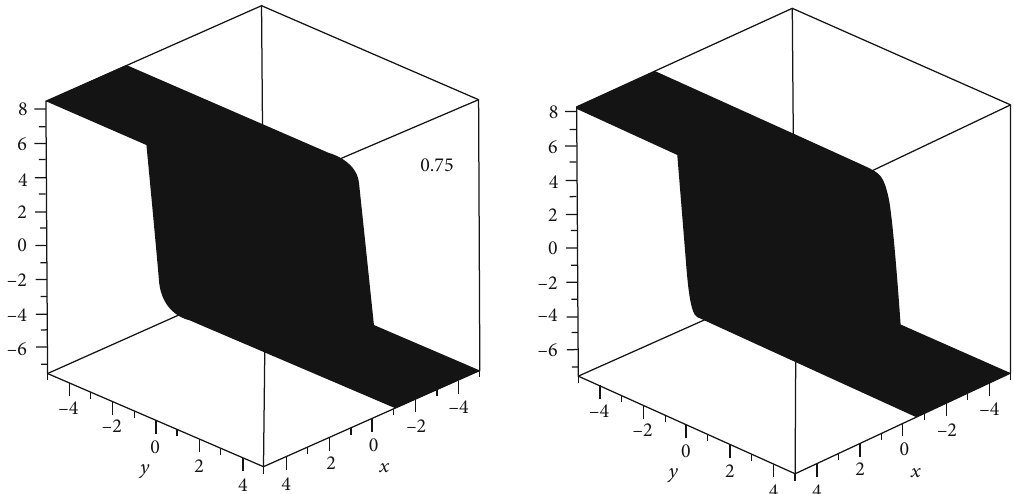
Figure 2: Graphical view of the analytical solution for J ð ζ , ρ Þ at δ = 0 : 8,0 : 6 of system 1